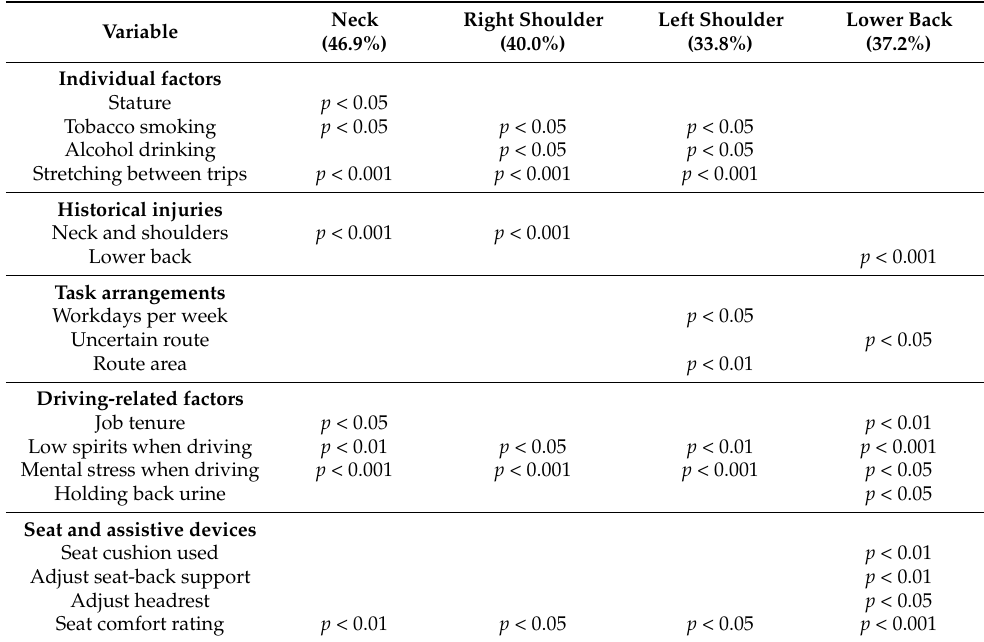
Table 5. Risk factors associated with WMSDs for 4 body parts.